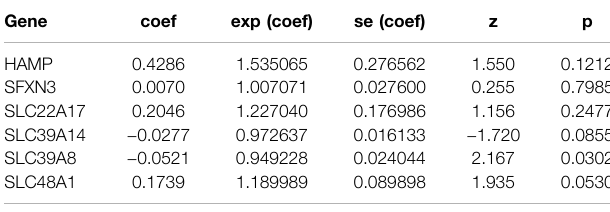
TABLE 1 | Multivariate Cox coef fi cients of iron metabolism related genes.